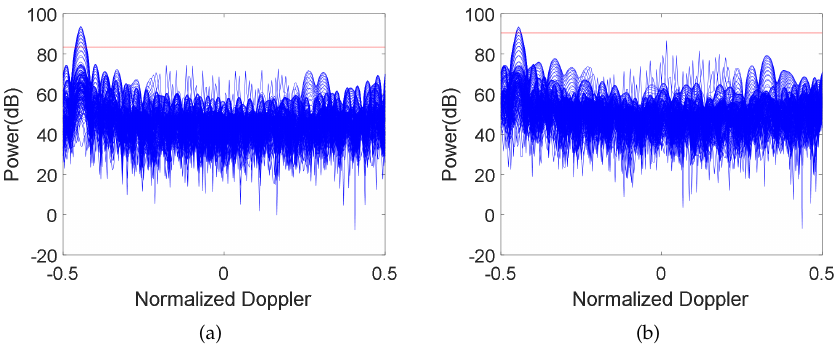
Figure 16. The results after detection, when there is a target: ( a ) traditional method; ( b ) pro- posed method.